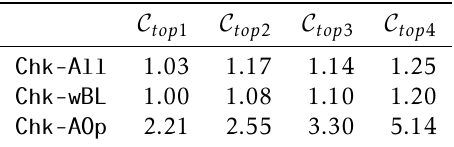
Table 5. Normalizedtimeconsumptionforeach